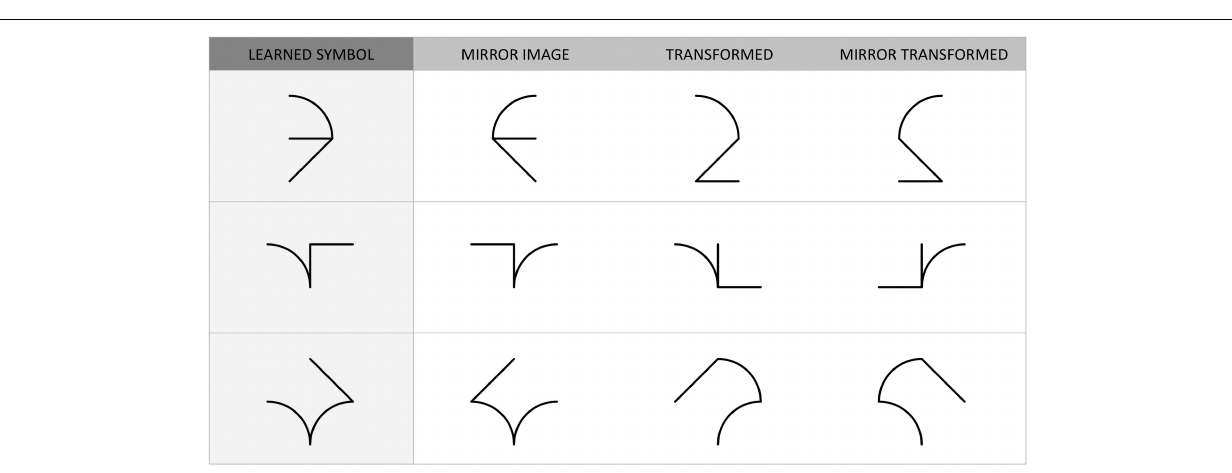
FIGURE 3 | Examples of trials in the 4AFC recognition